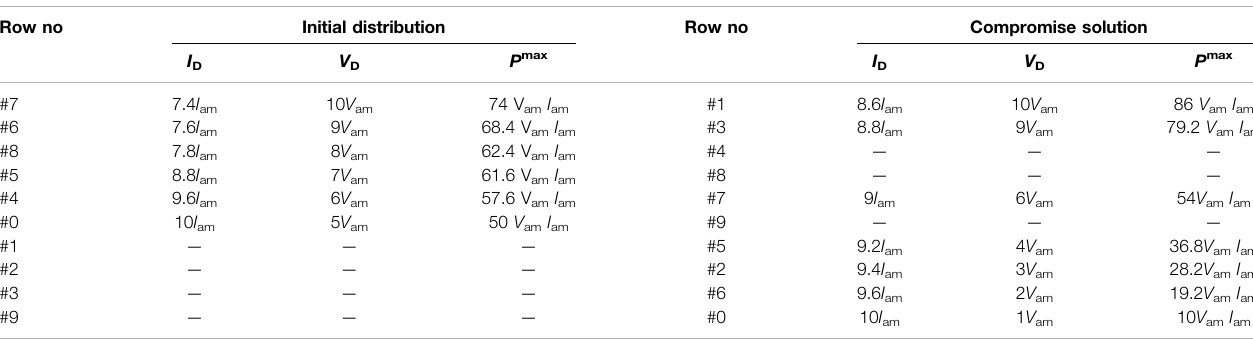
TABLE 3 | Comparison of theoretical output between the compromise solution and the initial distribution at the 5th minute Row no Initial distribution Row no Compromise